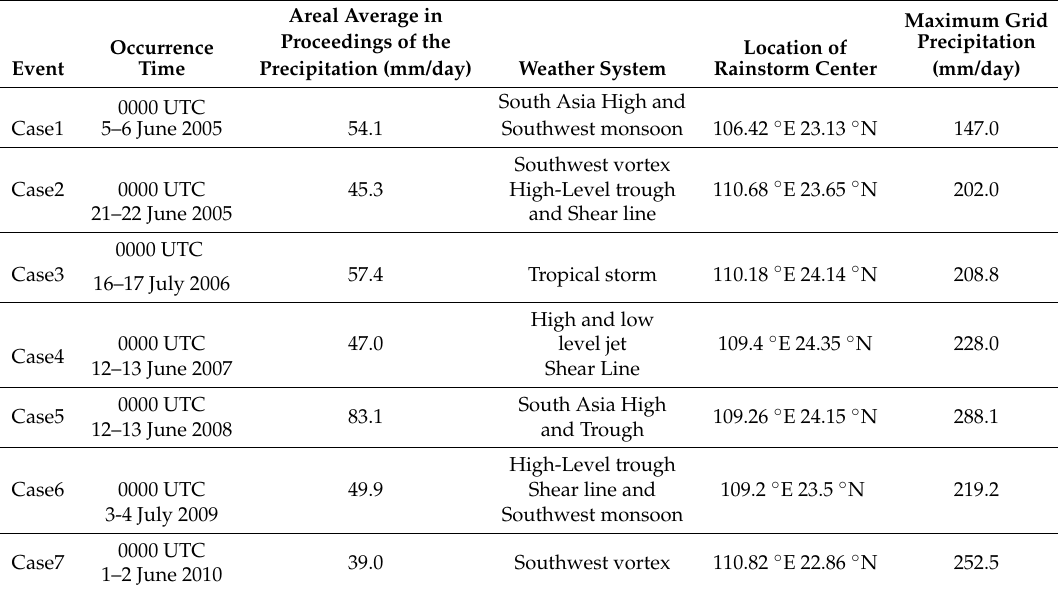
Table 2. Selected rainstorms over the Xijiang Basin.